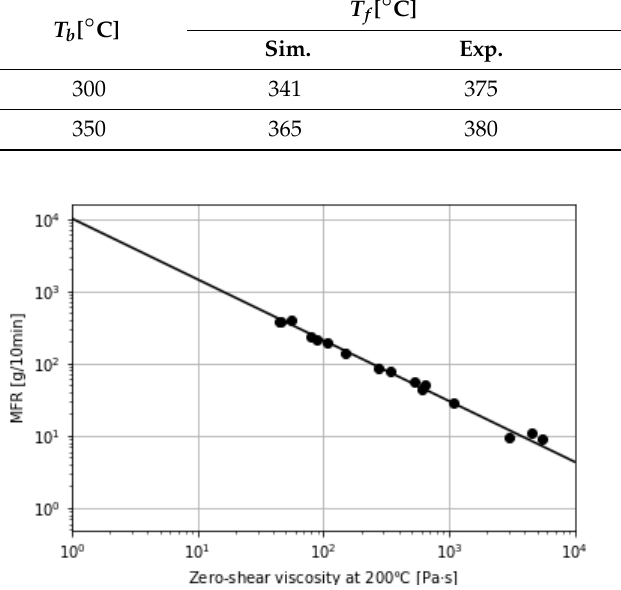
Figure 14. Calibration curve of MFR for